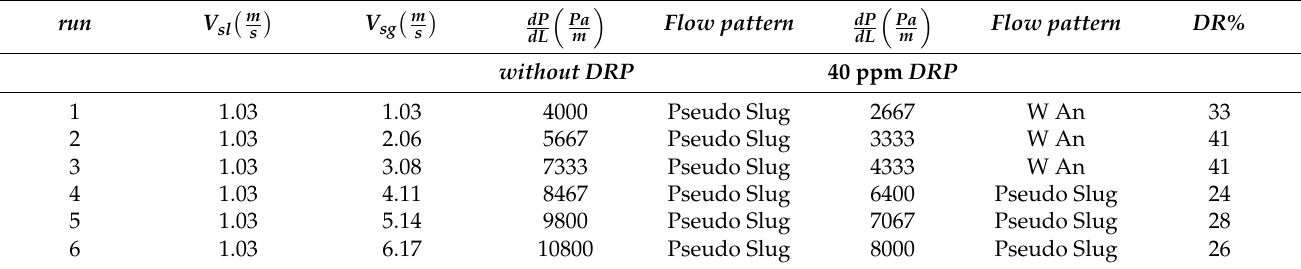
Table A4. Frictional pressure gradient and transition of Pseudo Slug flow regime using 40 ppm DRP.